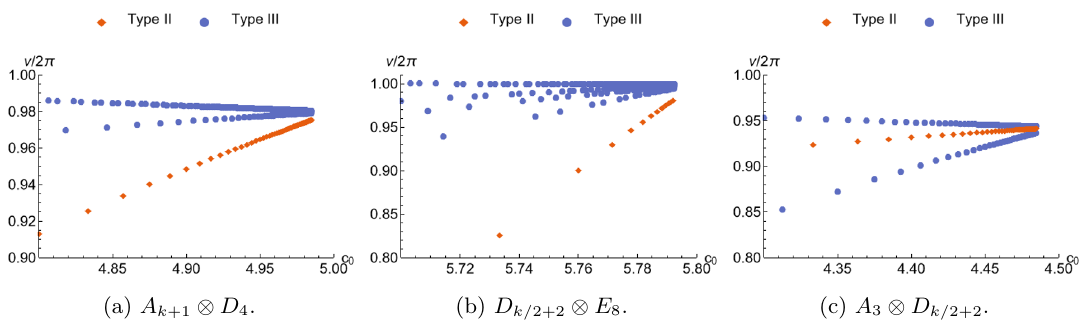
Figure 1 . Comparison of the largest value of ν/ 2 π as a function of the central charge for A k +1 ⊗ D 4 1a, 1c. The maximal value ν/ 2 π can assume is 1, corresponding D ⊗ E 8 1b and A 3 ⊗ D k/ 2+2 k/ 2+2